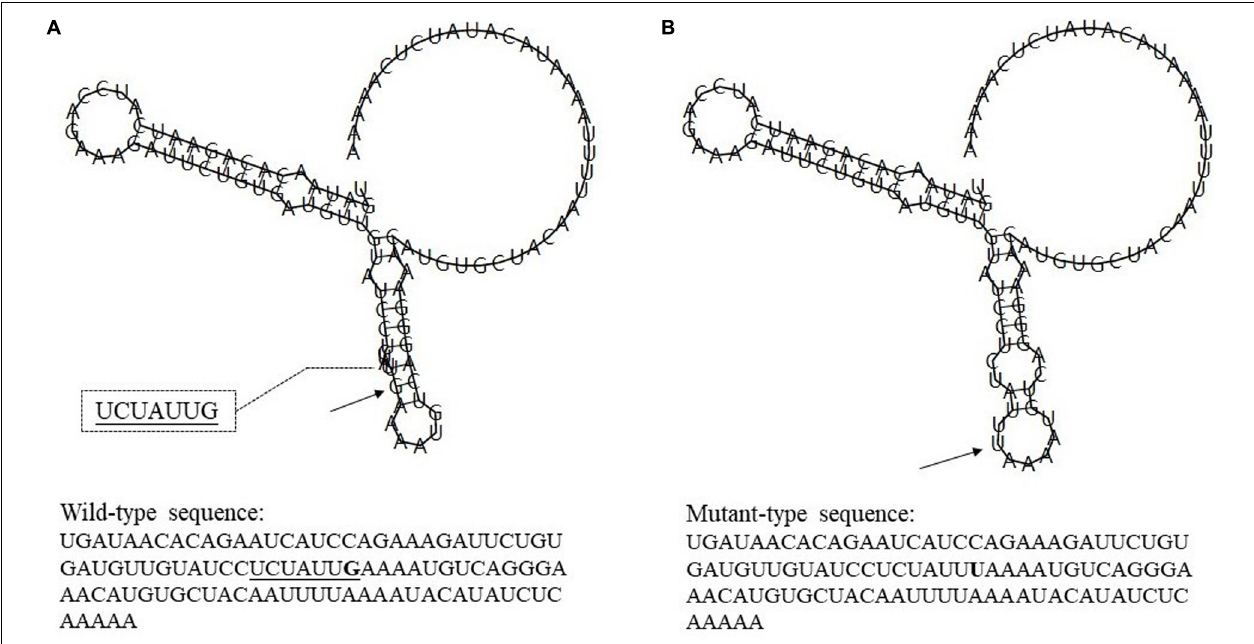
FIGURE 2 | The influence of rs7514229 variants on TNFSF4 mRNA centroid secondary structures. Changes in the local structure were illustrated by the RNAfold Web Server. The arrows indicate the location of the mutation (50 bases upstream and 50 bases downstream of the mutation) shown in bold type. The underlined sequence has overlapping nucleotide letters. TNFSF4 rs7514229 changes the local structure and the minimum free energy of the mRNA centroid secondary structure (one with the smallest base pair distance) from − 17.30 kcal/mol (A) to − 16.60 kcal/mol (B) . The wild-type and mutant-type sequences are also